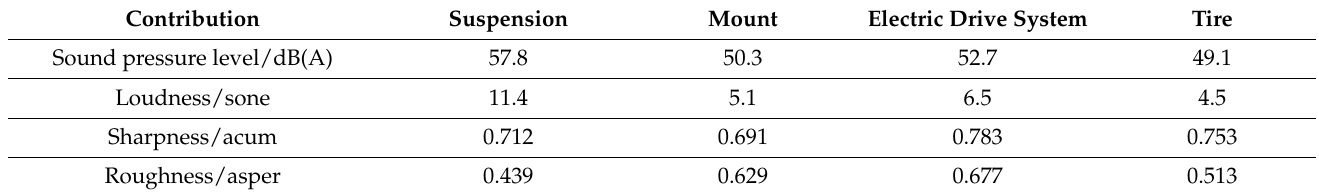
Table 5. Sound quality contribution to the paths of interior noise of PEV under 50